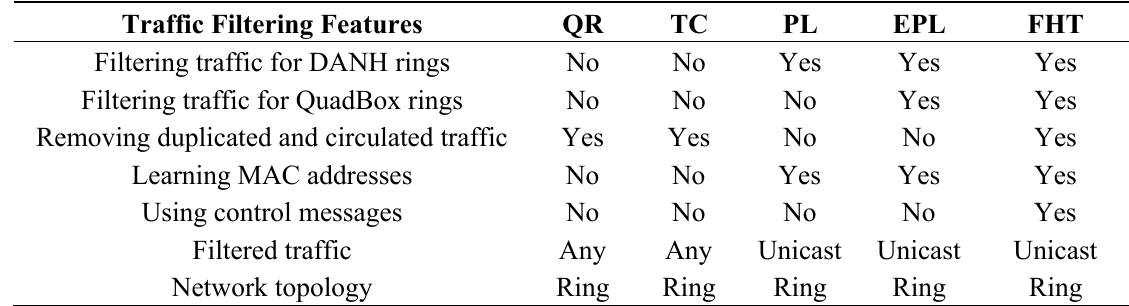
Table 2. Characteristics of traffic filtering-based